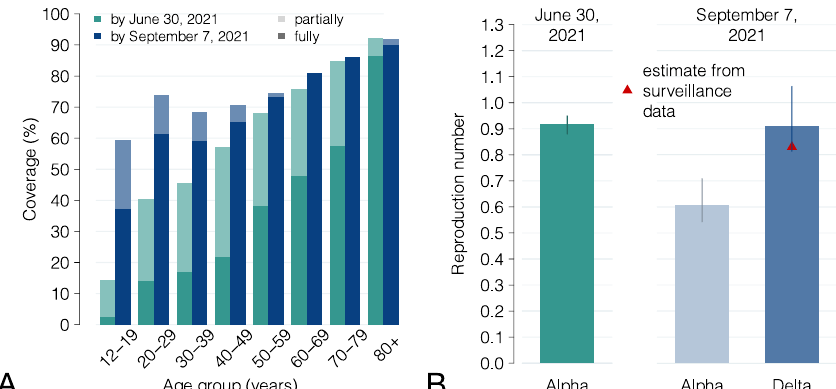
Fig. 3 Vaccination coverage by June 30 and September 7, 2021, and effect of the replacement of the Alpha variant by the Delta variant. A Comparison between the fraction of the Italian population that was partially and fully vaccinated by June 30, 2021, and by September 7, 2021, by age group. B Green: net reproduction number on June 30, 2021, when the Alpha variant was still largely dominant. Mean and 95% CI as reported in 45 . Light blue: estimated value of the reproduction number, given the progression of the vaccination program until September 7 and under the assumption that the Alpha variant remained dominant; bars: mean estimates; vertical lines: 95% CI; n = 300 stochastic model realizations. Dark blue: the same effect under the assumption of a 50% increase in transmissibility to reproduce the replacement of the Alpha variant with the Delta, occurred during the summer of 2021 11 – 13,25 ; bars: mean estimates; vertical lines: 95% CI; n = 300 stochastic model realizations. Red triangle: value of the reproduction number as estimated from surveillance data 27 ; for this estimate, the 95% CI is not visible at the scale of the plot.